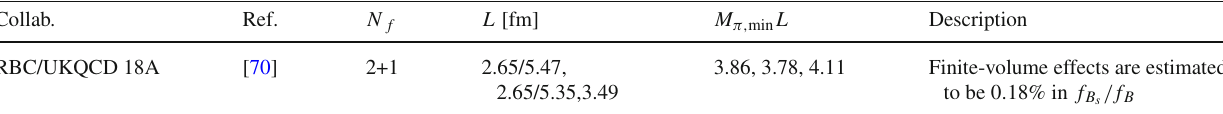
Table 142 Finite-volume effects in determinations of the B - and B s -meson decay constants for N f = 2 + 1 simulations. Each L -entry corresponds to a different lattice spacing, with multiple spatial volumes at some lattice spacings Collab.